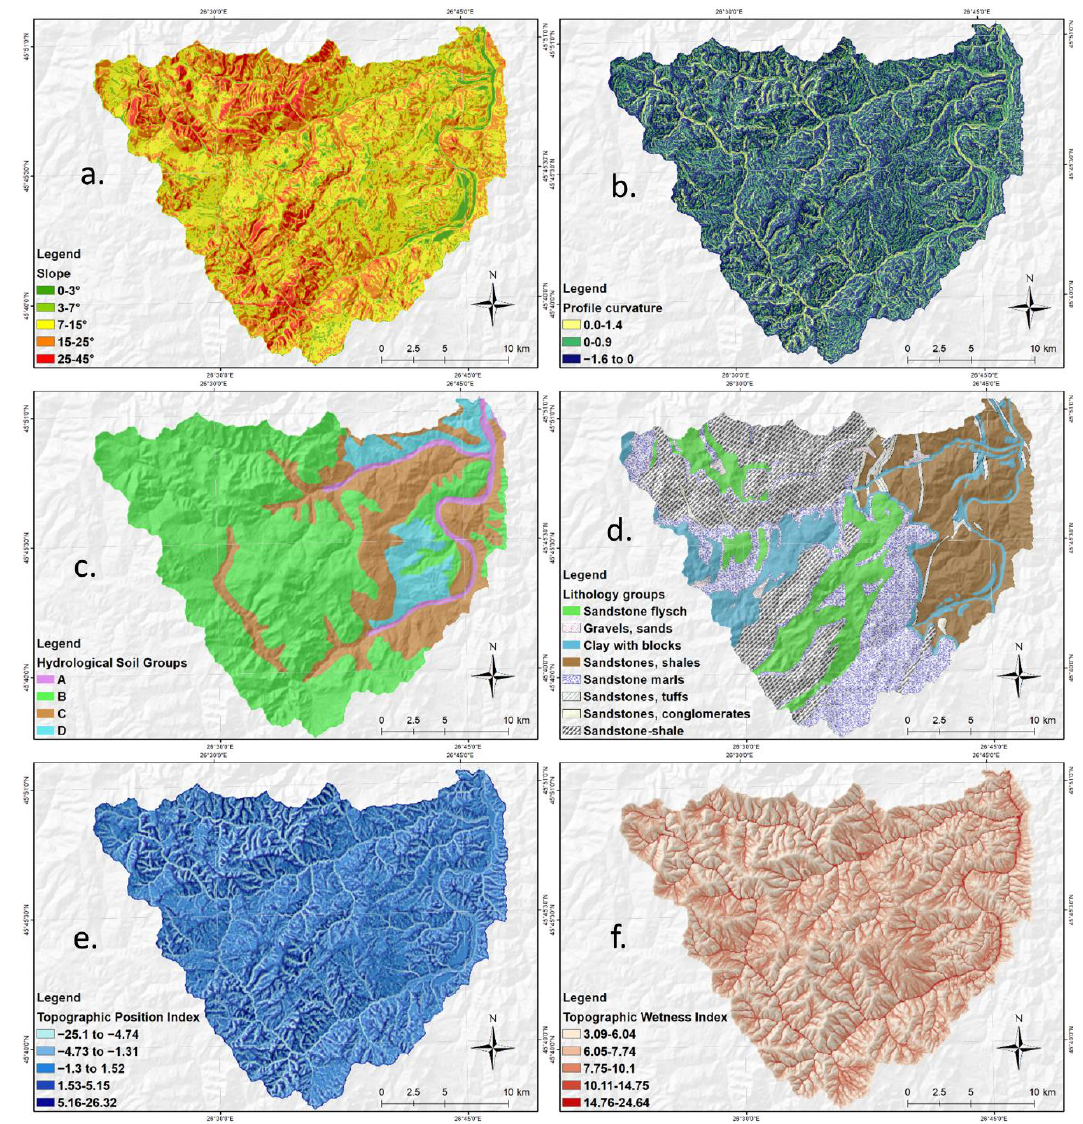
Figure 4. The factors considered for the FFPI calculation: ( a ) slope, ( b ) profile curvature, ( c ) hydrological soil group, ( d ) lithology, ( e ) topographic position index, and ( f ) topographic wetness index.